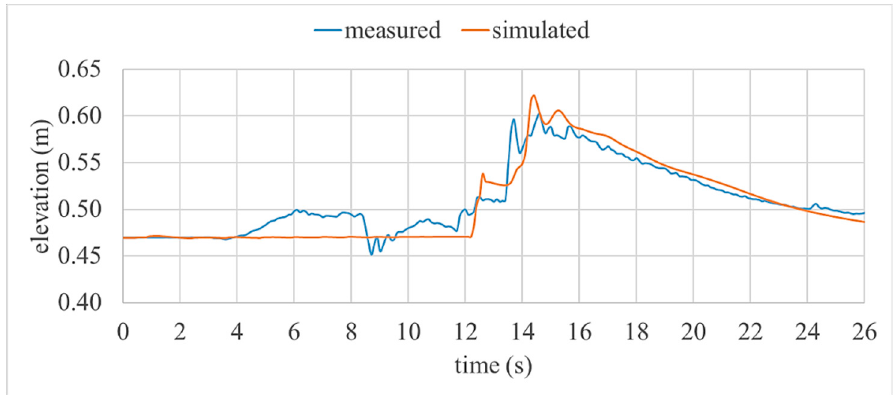
Figure 28. Comparison of measured water level variations and simulated data at E.